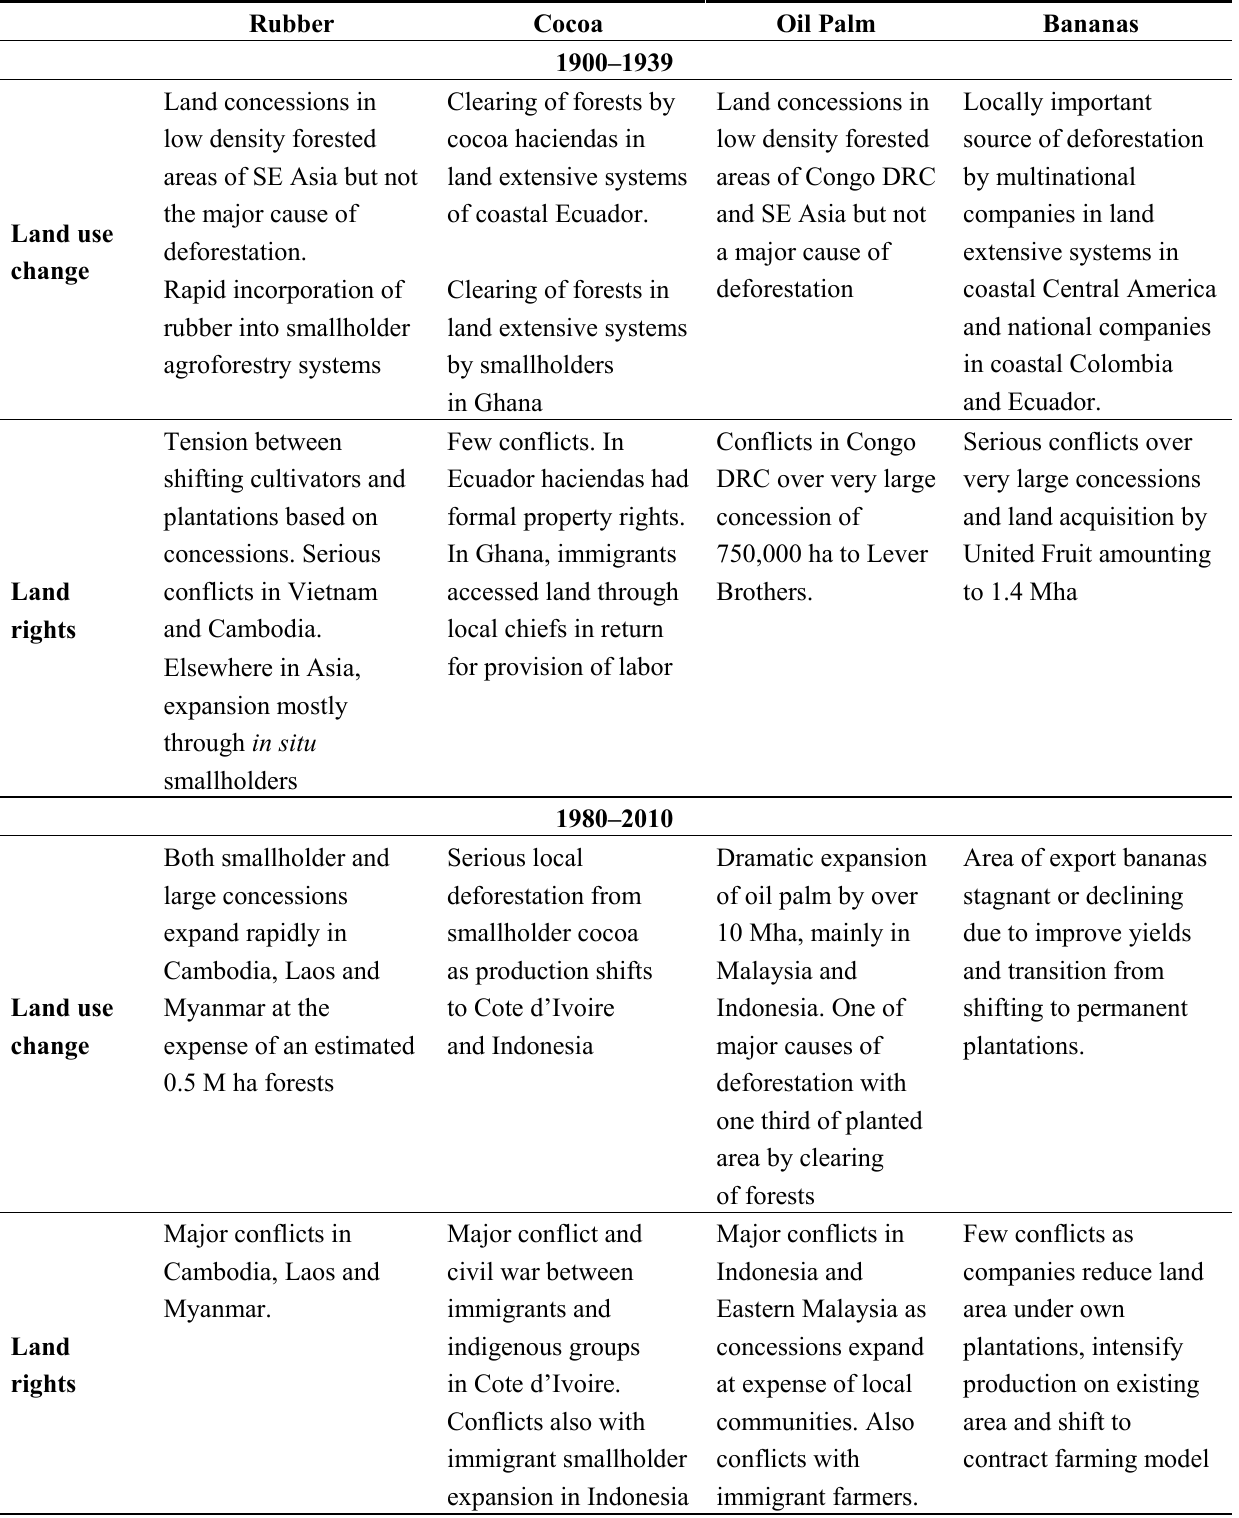
Table 2. Summary of major outcomes for land use and land rights from expansion of four tropical commodities in the early and late 20th